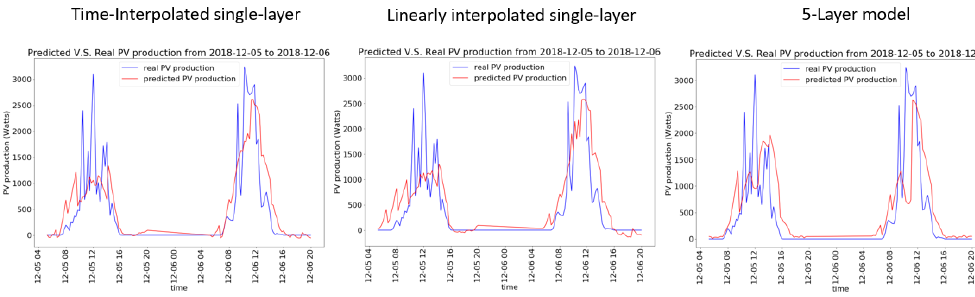
Figure 4. Examples of real vs. forecasted PV production for cloudy